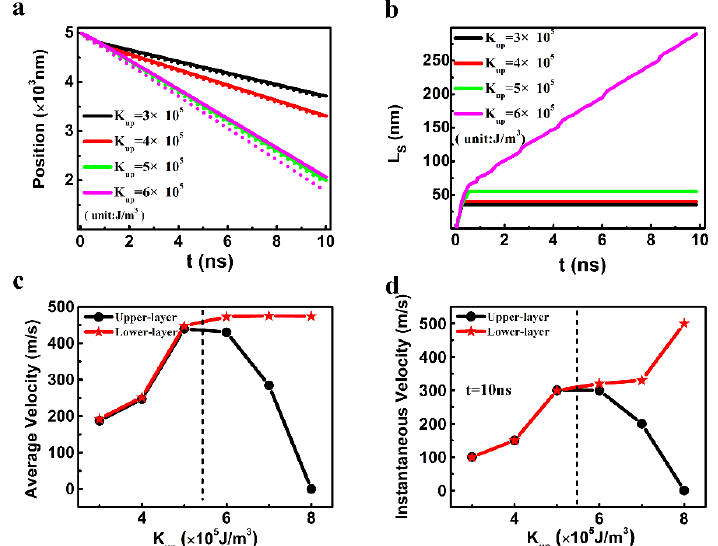
Figure 5. ( a ) The temporal central positions of the DWs in the two layers (The solid and dashed lines represent the results in the upper layer and in the lower one, respectively.), ( b ) the temporal length of the staggered domains of the SAF racetrack, ( c ) the average velocity, and ( d ) the instantaneous velocity of the DW as a function of the anisotropy constant of the upper layer. Other parameters of J ex , D, and K L were fixed as − 0.15 mJ / m 2 , 0.75 mJ / m 2 , and 2.5 × 10 5 J / m 3 , respectively.